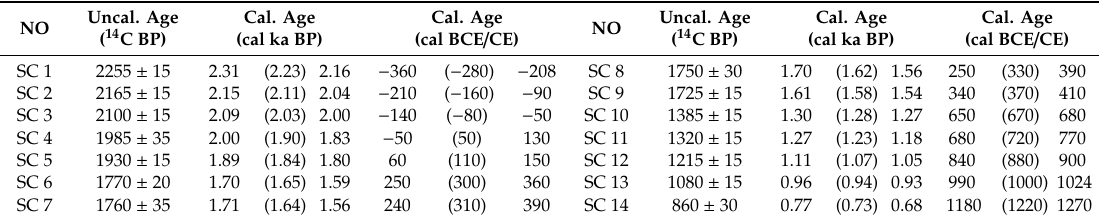
Table 1. Radiocarbon ages of trunks found within the glacial forefield. Most probable ages of the calibrated dates in parentheses, spanned by maximum and minimum ages of the 2 σ range.